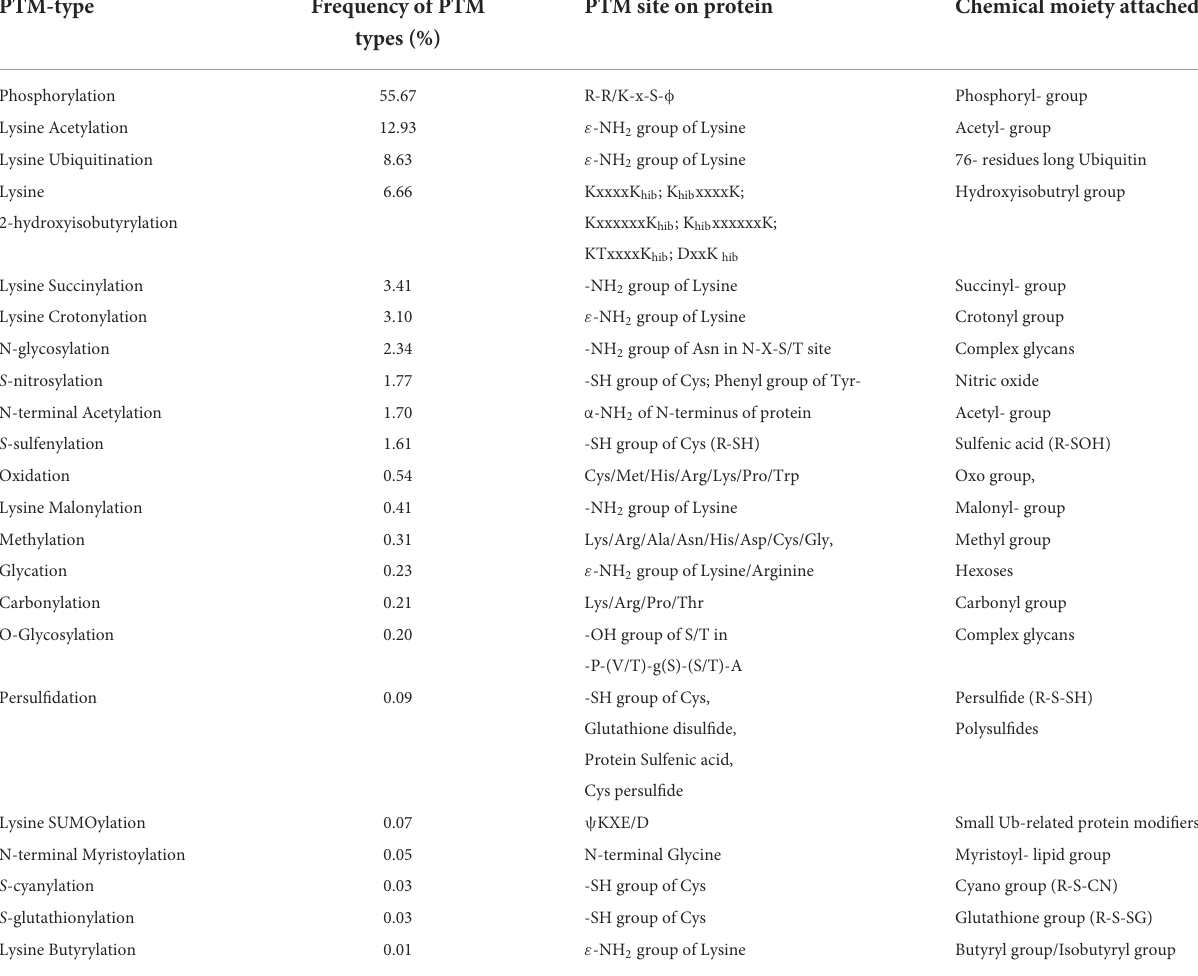
TABLE 1 Frequency of post-translational modification (PTM) types, sites, and chemical moieties covalently attached to proteins in various PTM